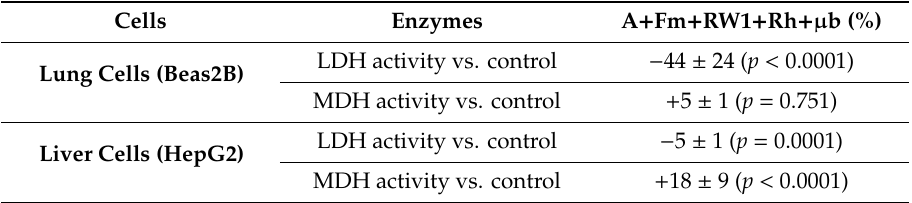
Table 4. Lactate dehydrogenase (LDH) activity and mitochondrial (MDH) activity after lung and liver cells’ exposure to organic extracts of contaminated soil planted with alfalfa and combined with Fm, RW1, Rh, and µb compared to soil samples before phytoremediation. p values in bold indicate significant differences between A+Fm+RW1+Rh+µb condition and control soil before phytoremediation according to the Mann–Whitney test ( p ≤ 0.05). Values are means + s.d. ( n = 12).